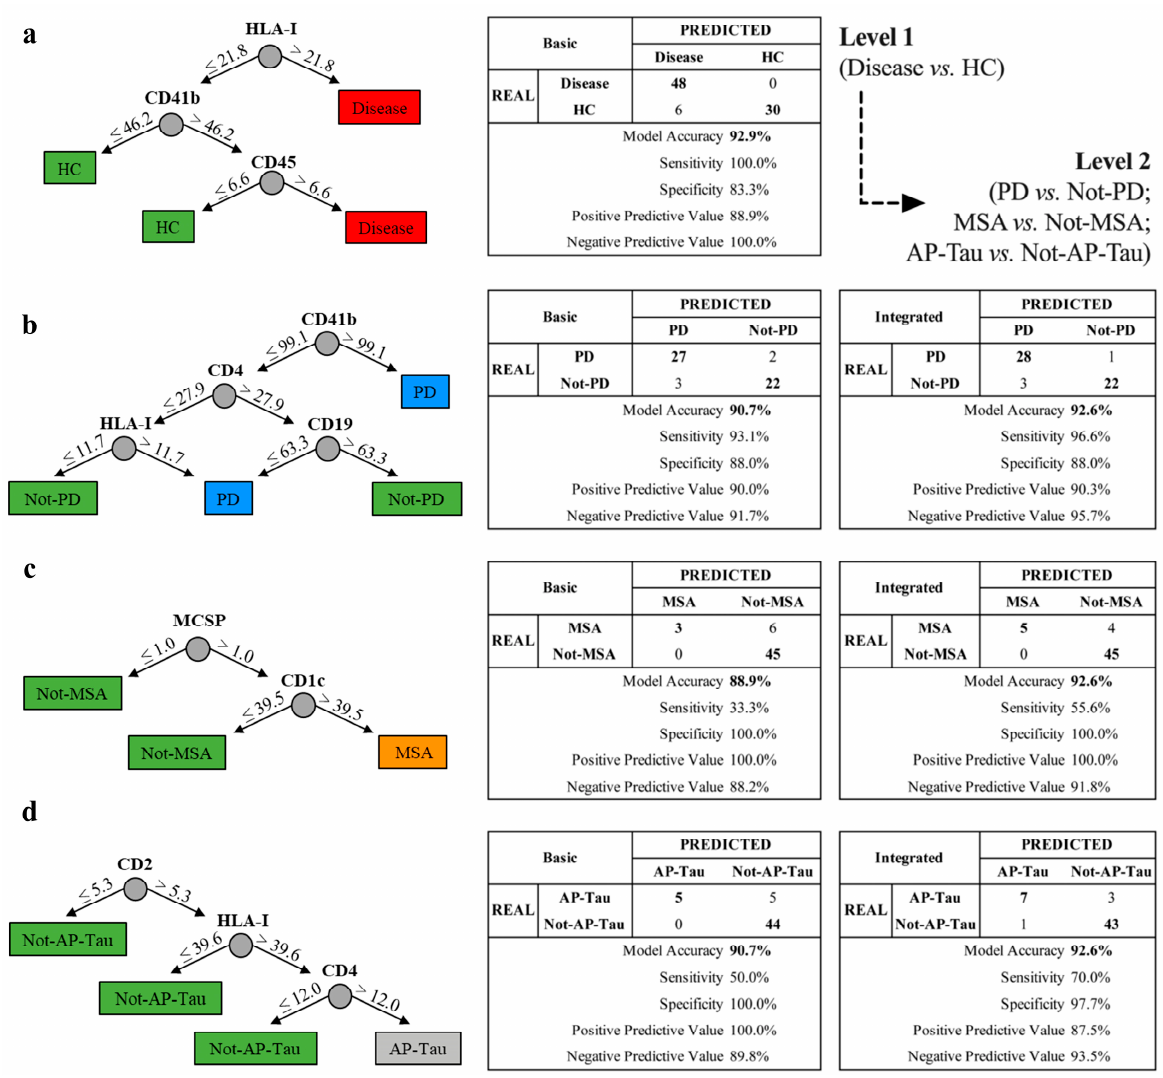
Figure 6. Diagnostic modelling. Development of a 2-level integrated random forest (RF) model to discriminate patients with Parkinson’s disease (PD), multisystem atrophy (MSA), or atypical parkinsonism with tauopathies (AP-Tau) in the plasma discovery cohort ( n = 84; characteristics of patients are reported in Table S4). ( a ) Level 1 of RF model, discriminating subjects with neurodegenerative diseases from healthy controls (HC). Patients classified as “disease” at level 1 were introduced to level 2. ( b ) Two-level RF model, discriminating PD from non-PD patients. ( c ) Two-level RF model, discriminating MSA from non-MSA patients. ( d ) Two-level RF model, discriminating AP-Tau from non-AP-Tau patients. Confusion matrix (basic vs. integrated version) and a representative classification tree are shown for each RF model. In bold mark are represented the numbers of correctly predicted diagnosis and overall accuracy of the